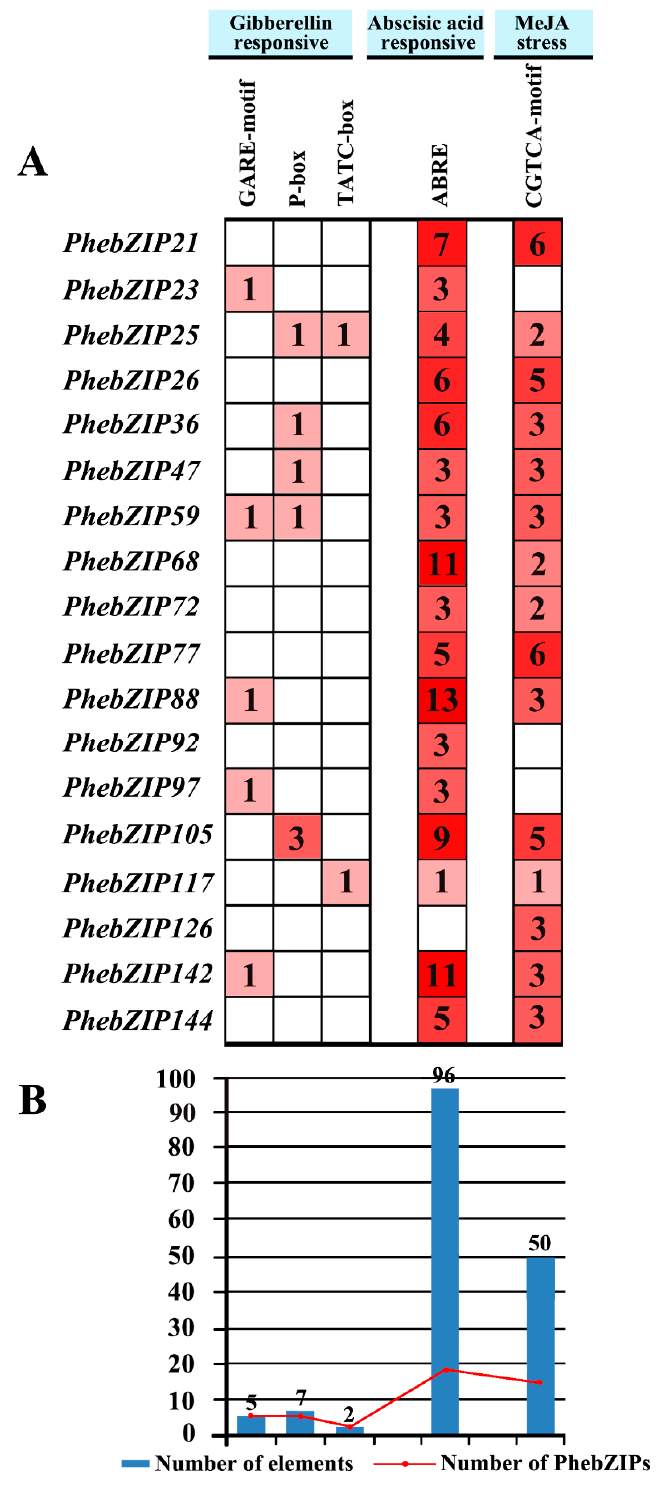
Figure 6. Analysis of Cis -acting elements in the promoter regions of PhebZIP genes. ( A ) The number of each cis -acting element in the promoter regions (2 kb upstream of the translation start site) of PhebZIP genes. ( B ) Statistics for the total number of PhebZIP genes, including the corresponding cis -acting elements (red dots) and the total number of cis -acting elements in the PhebZIP gene family (blue boxes). Based on functional annotations, the cis -acting elements classify into five major groups: gibberellin, abscisic acid, and MeJA.